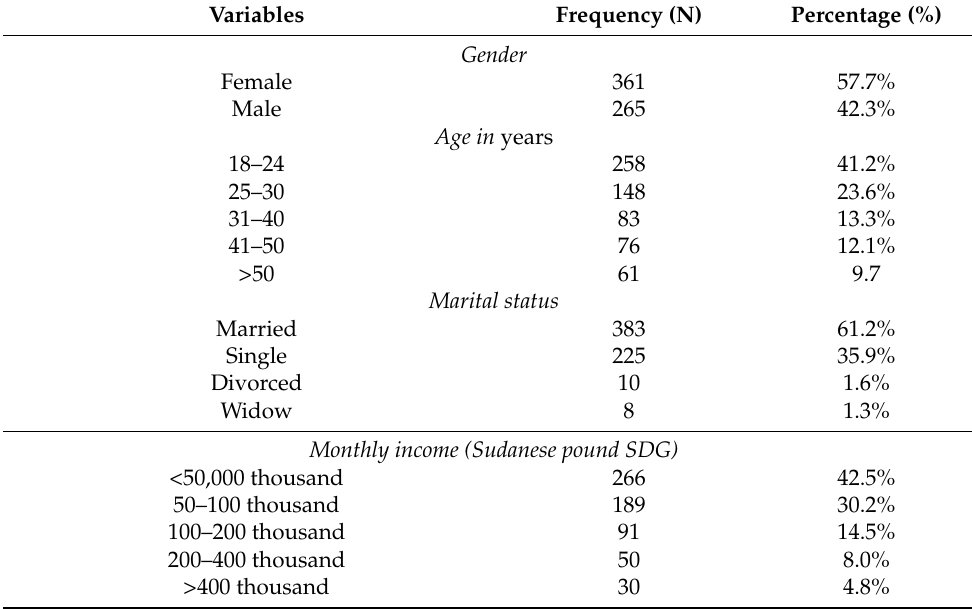
Table 1. Participants’ demographics (N =